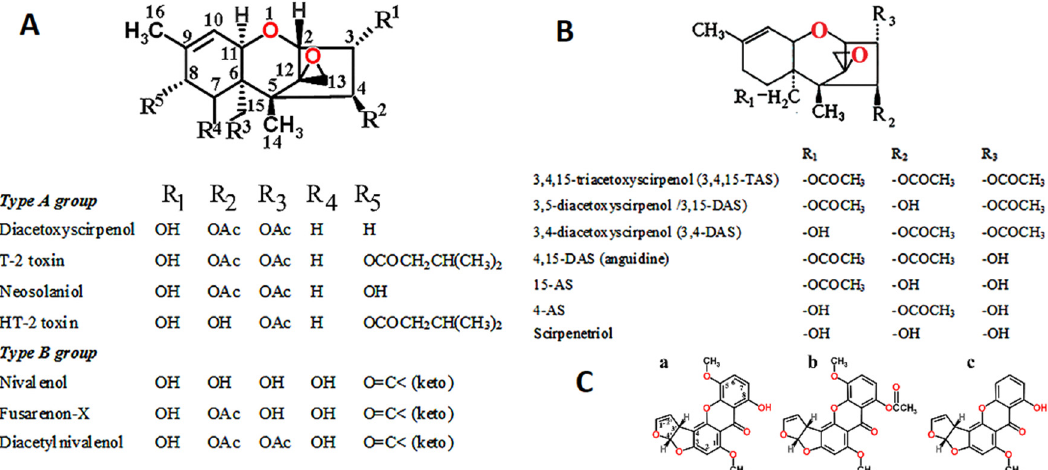
Figure 3. Fusarium toxins. Type A trichothecenes: ( A ) diacetoxyscirpenol, T-2 toxin, neosoleniol, HT-2 toxin. Type B trichothecene group: nivalenol, fusarenon-X, diacetylnivalenol. ( B ) Anguidine analogues of trichothecenes: 3,4,15-TAS; 3,-15 DAS; 3,4-DAS; 15 DAS; 4,15-DAS (anguidine); 15-AS; 4-AS; scirpenetriol. ( C ) The chemical structure of antileukemic 5-methoxysterigmatocystin (5-MS) derivatives. ( a ) 5-MS, ( b ) O-acetyl-5-MS, ( c ) sterigmatocystin. The ring structure consists of 2 five-membered bisfurano rings and 3 six-membered rings forming the xanthone skeleton. Metabolic pathways of Fusarium mycotoxins are diversified. Formulas permitted by